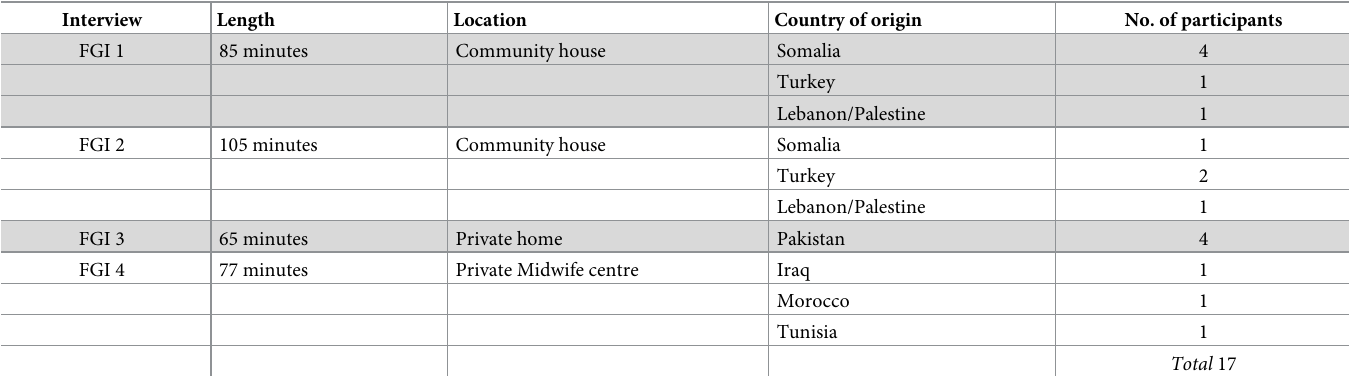
Table 2. Characteristics of the focus group